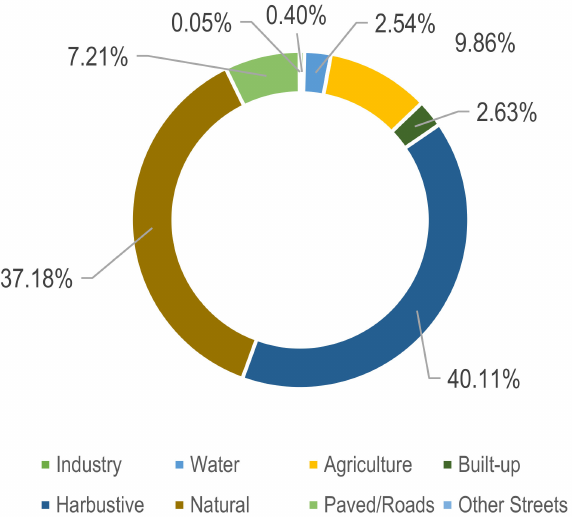
Figure 1. Land-use Land Cover Composition in the Area of Interest. Overall, anthropic-related uses occupy more than 10% of the AOI while urgently requiring the need to govern and steer the incoming urban development process (see Figure 2).